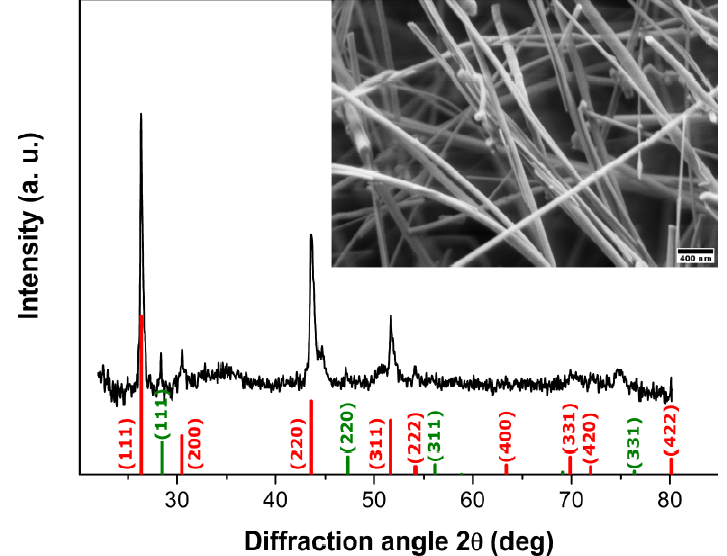
Figure 5 . Representative powder X-ray diffraction (PXRD) pattern of ZB InP:Ga nanowires (NWs) (red = reference pattern: Inorganic Crystal Structure Database (ICSD) 73-1983; green = Si from substrate) with SEM image of NWs grown at 350 °C